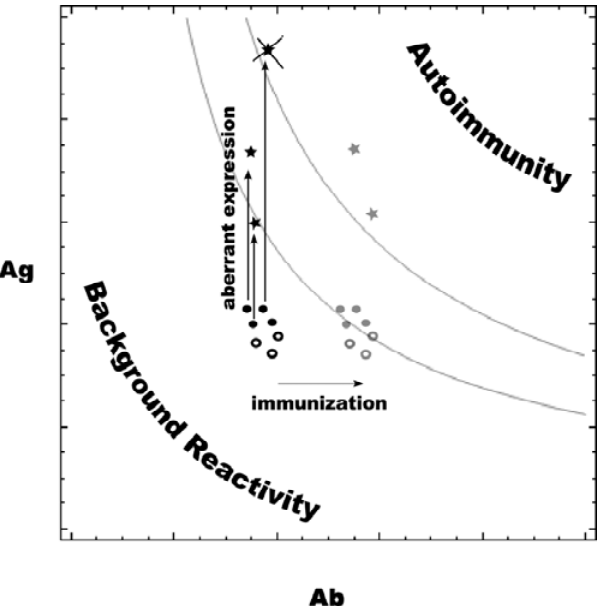
Figure 9. A model of the relationship between self/tumor-associated antigen densities (Ag) and natural antibody concentrations